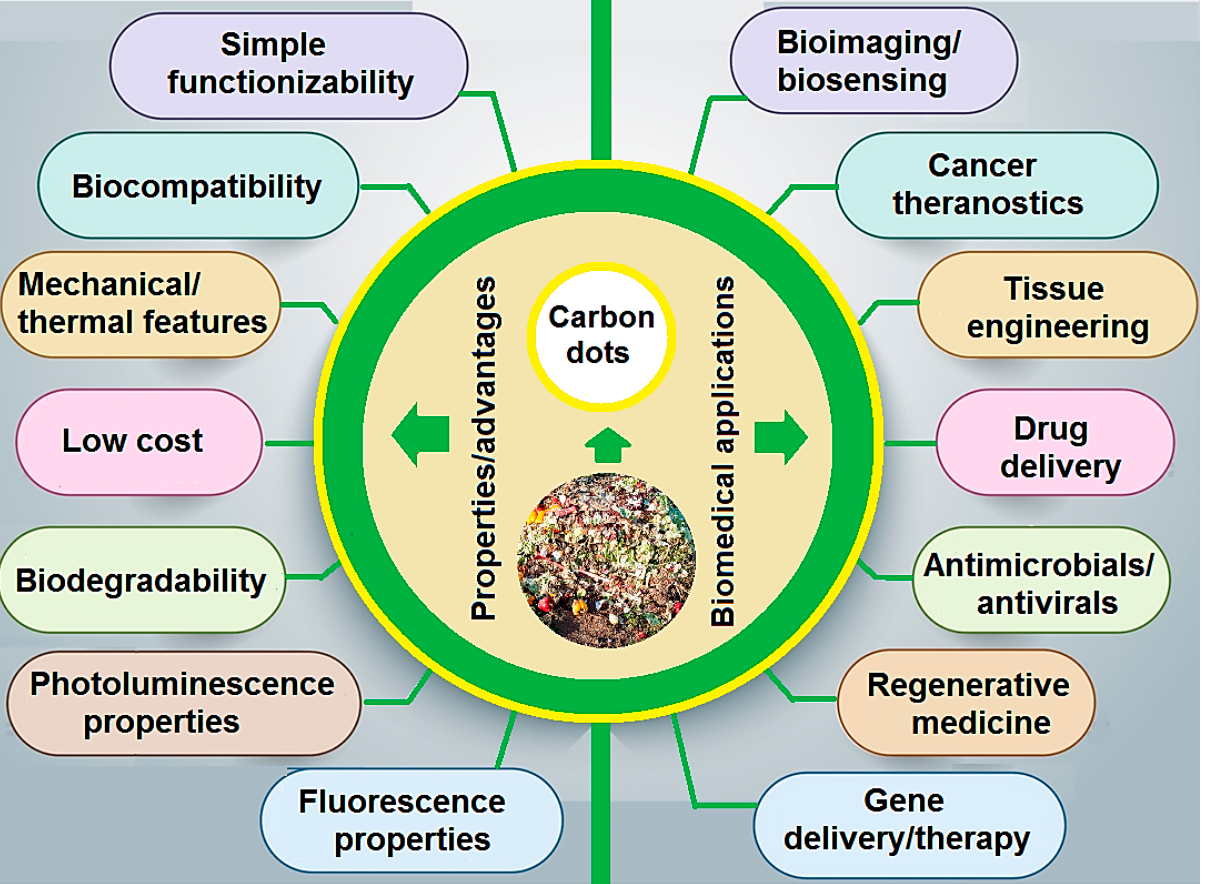
Figure 1. Advantages/properties and biomedical applications of biowaste ‐ derived CDs.